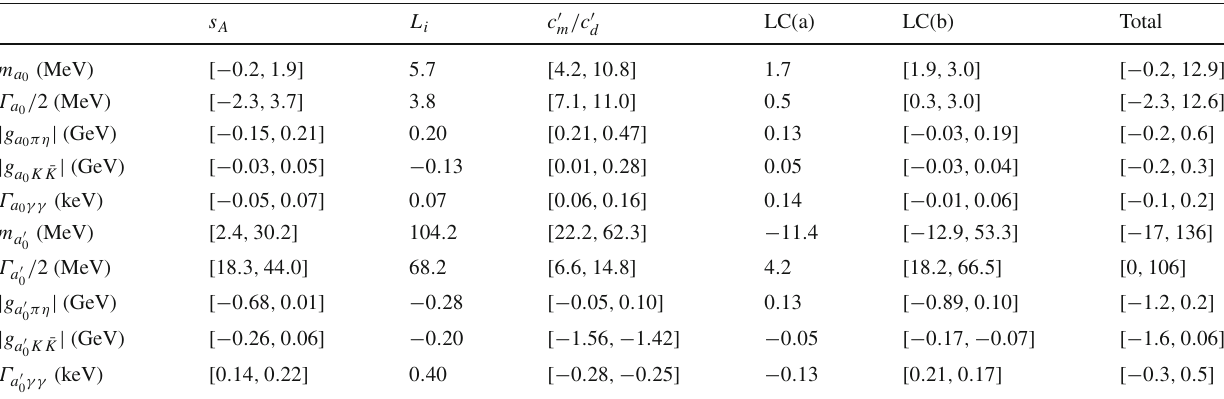
Table 4 Errors generated by varying the fixed parameters of the S -wave amplitudes, columns 5 and 6 refer to the left-cut (see